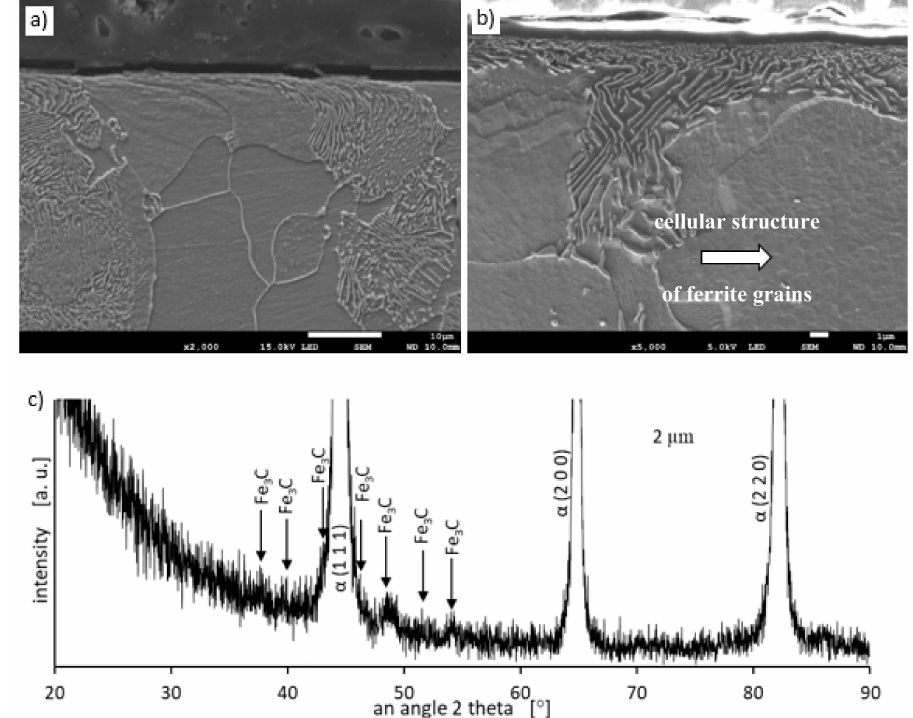
Figure 4. The microstructure of the surface layer after grinding to a depth of 2 µ m: ( a ) Visible deformation of pearlite and ferrite grains in the direction of peripheral speed [24], ( b ) cellular structure of ferrite grains depicted by arrow, ( c ) X-ray di ff